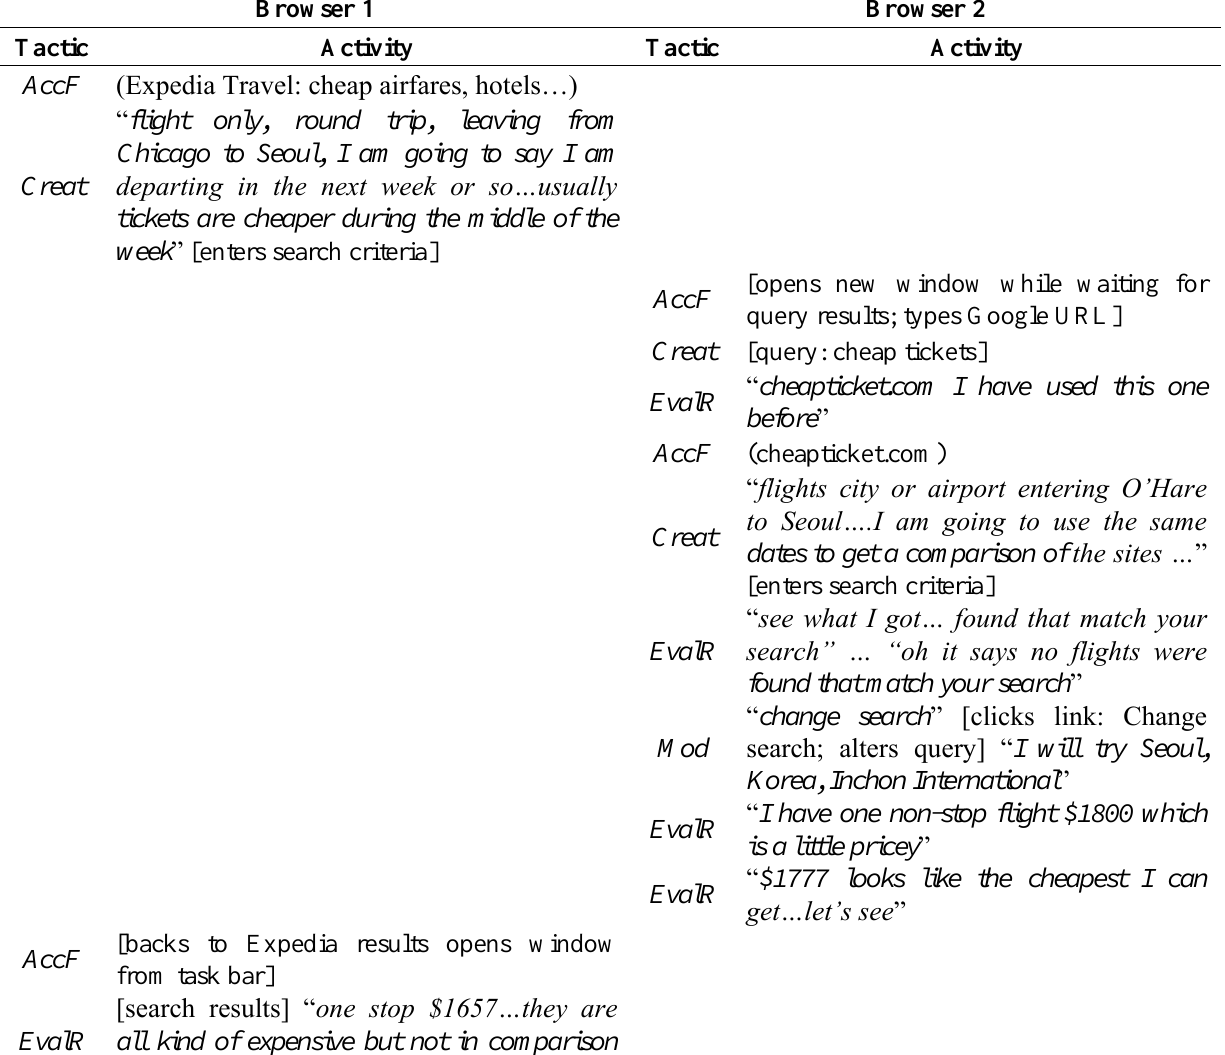
Table 10. Item comparison